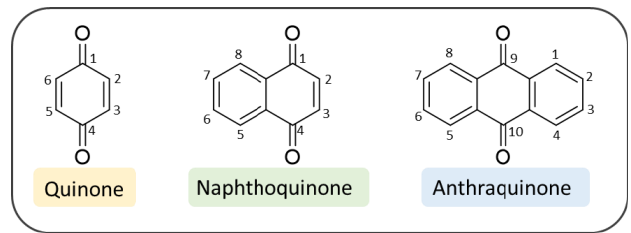
Figure 2. Structures of 1,4-quinone and related benzoquinones.